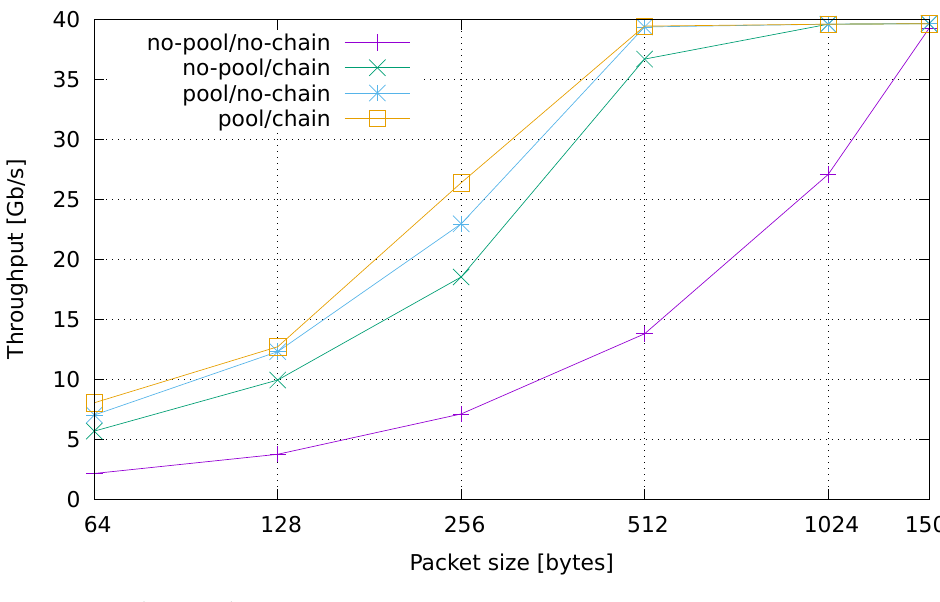
Figure 5. Speed test